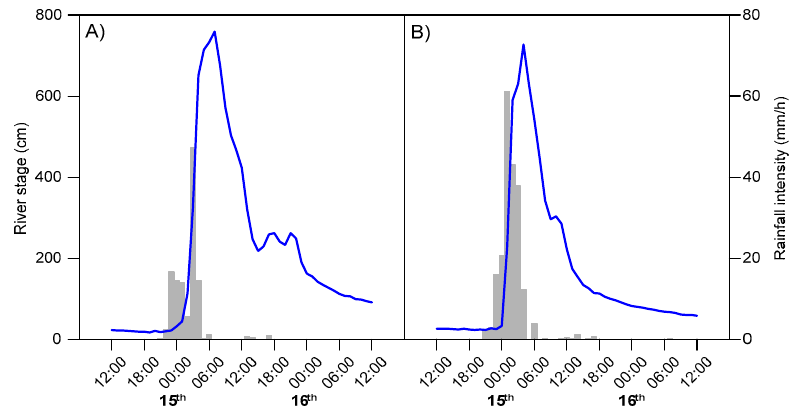
Figure 8. Storm hydrographs of the ( A ) Ponte Valentino (close to the ASI area) and ( B ) Pago Veiano stations. Figure 7 shows the station locations.